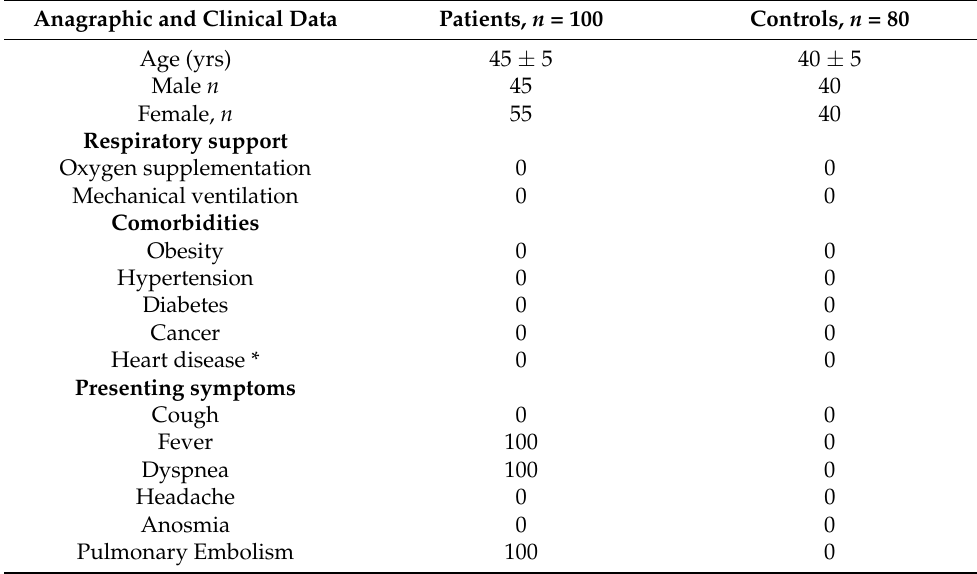
Table 1. Characteristics of coronavirus disease 2019 (COVID-19) patients. Anagraphic and Clinical